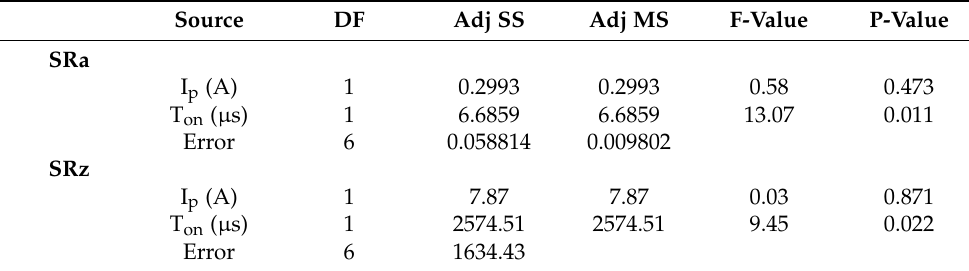
Table 6. ANOVA analysis for SRa and